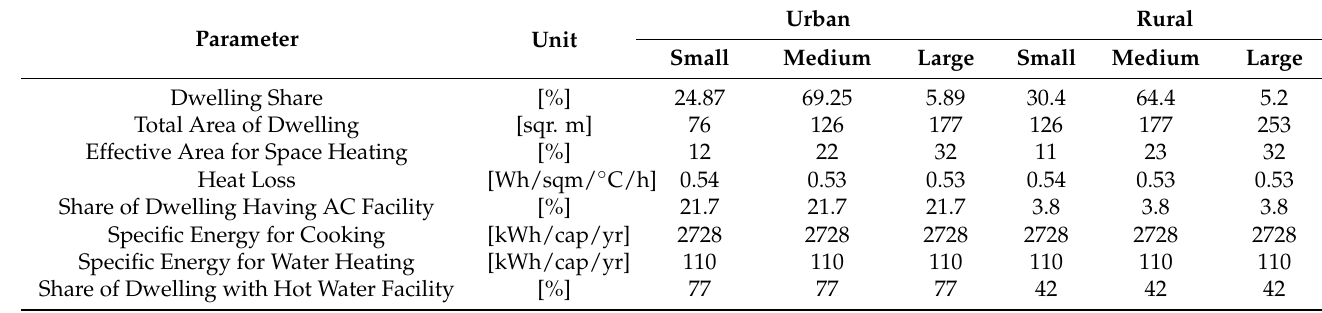
Table 7. Characteristics of different household categories [34,35,38,40–42].